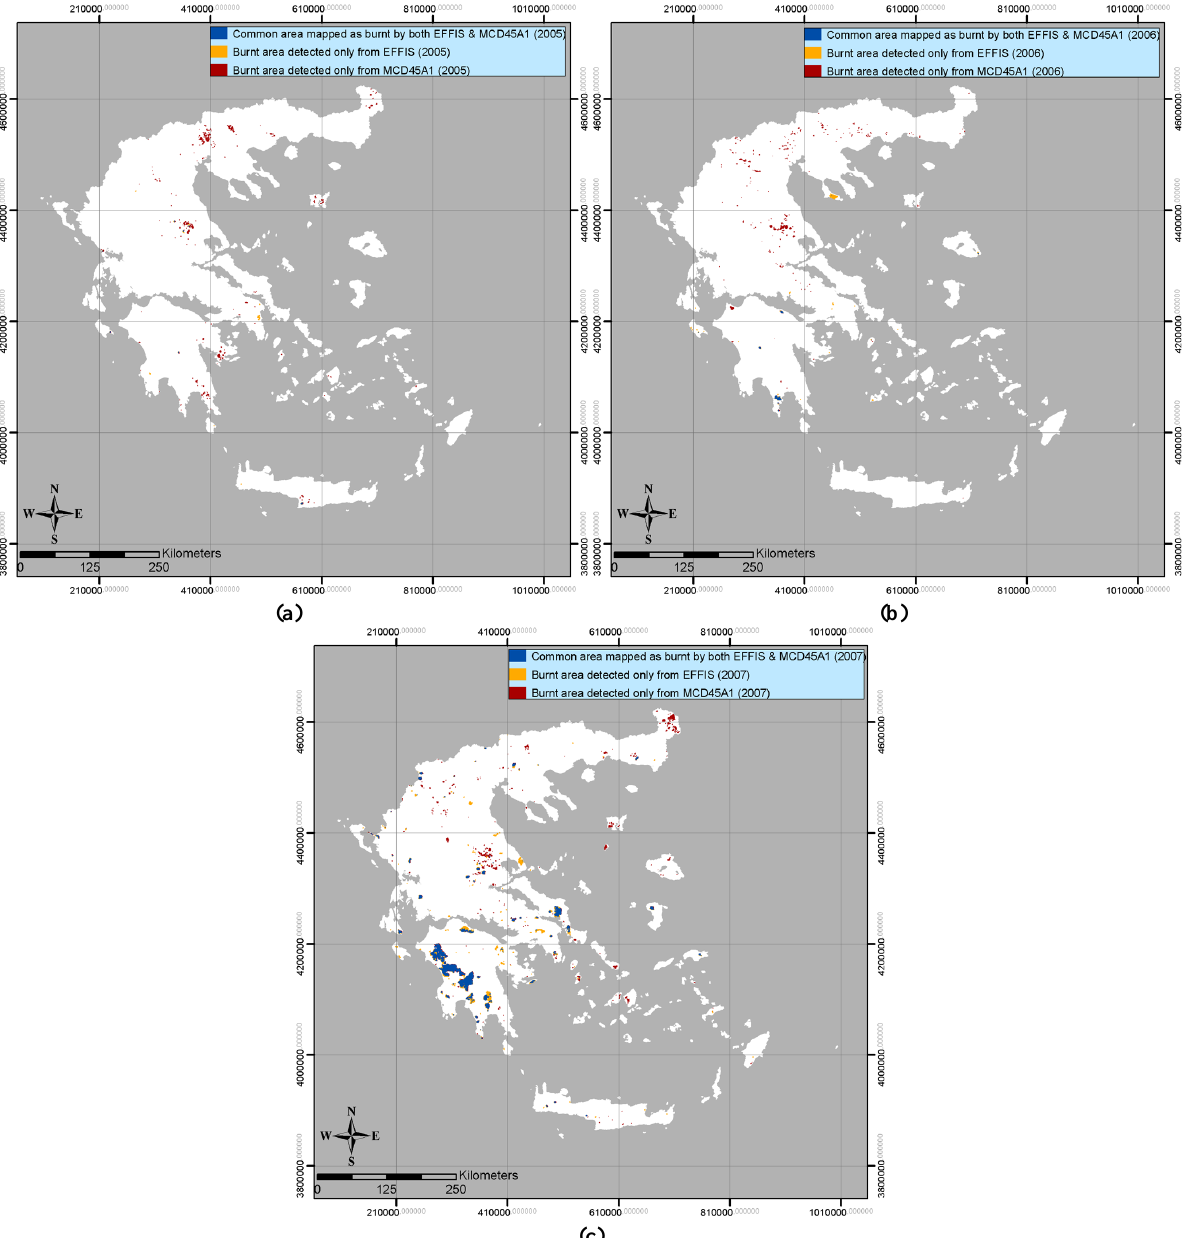
Fig. 4. Comparisons of the burnt area estimates for Greece between MCD45A1and EFFIS operational products for (a) 2005, (b) 2006 and (c)